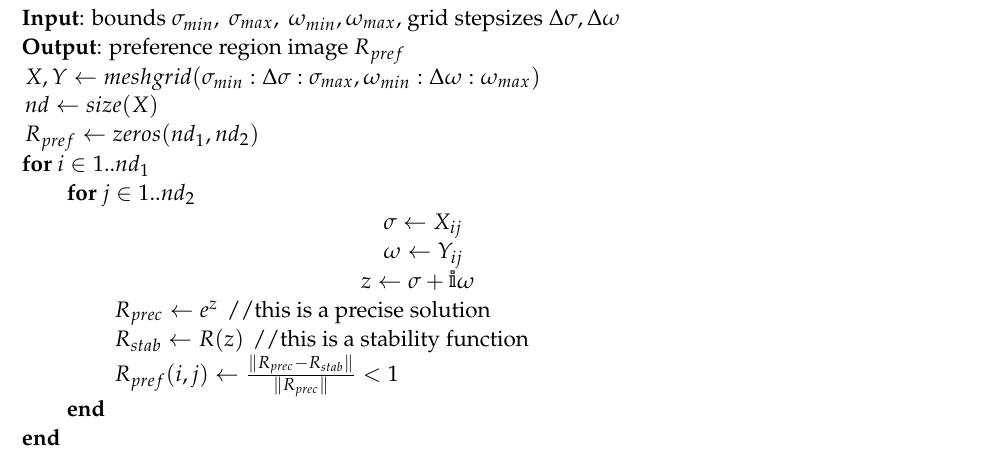
Algorithm 1: Plotting preference region for the one-dimensional test problem